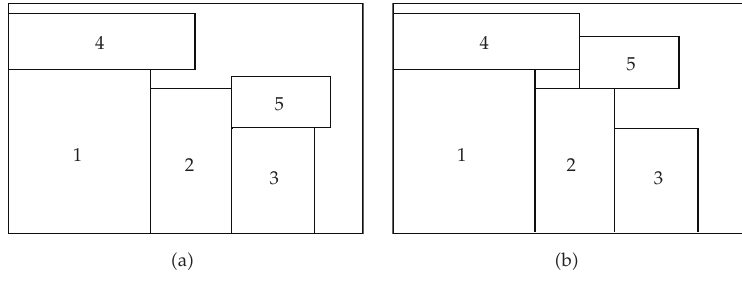
Figure 1: (cid:2) a (cid:3) Guillotine pattern, (cid:2) b (cid:3) nonguillotine